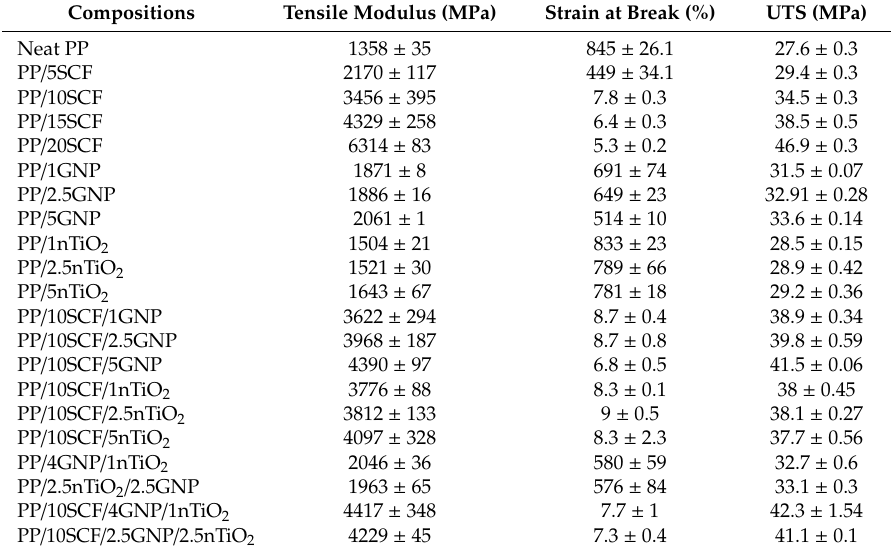
Table 6. Tensile modulus, strain at break, and ultimate tensile strength (UTS) of neat polypropylene (PP) and its